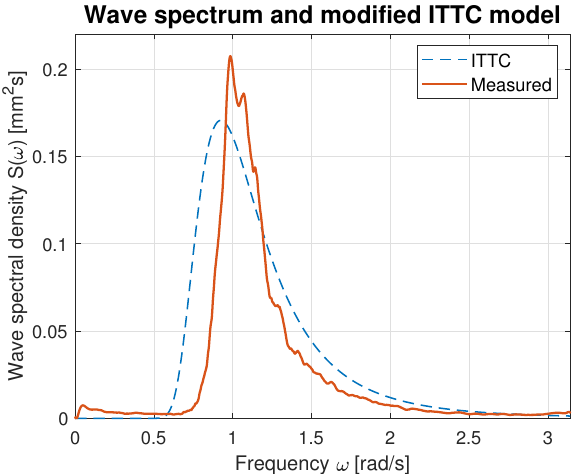
Figure 17. Comparison of the empirical wave spectrum evaluated for 5 BFT wind force in ship scale and the modified ITTC